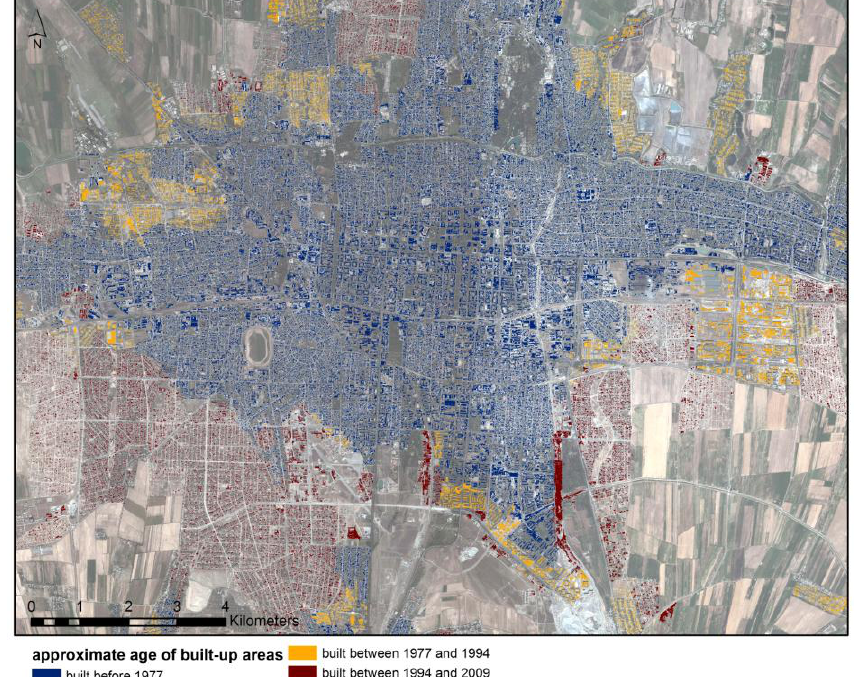
Figure 12. Spatio-temporal development of the building stock in Bishkek from 1977 to 2009. The approximate age of structures has been derived from a change-detection analysis of Landsat images and joined to the detailed built-up mask extracted from a Quickbird